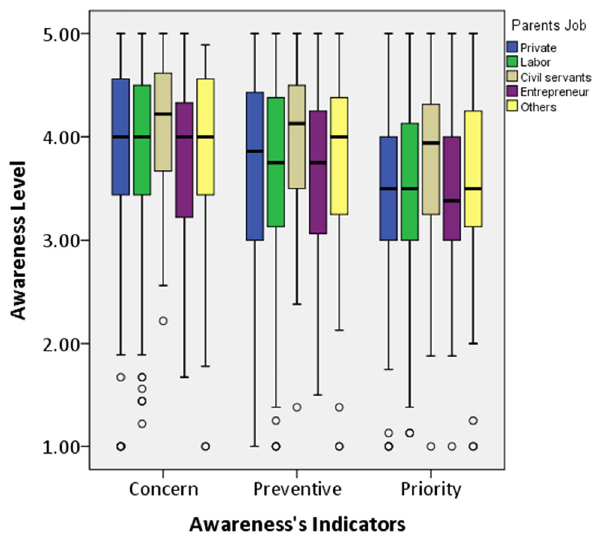
Figure 10: Student ’ s awareness level by parent ’ s job.